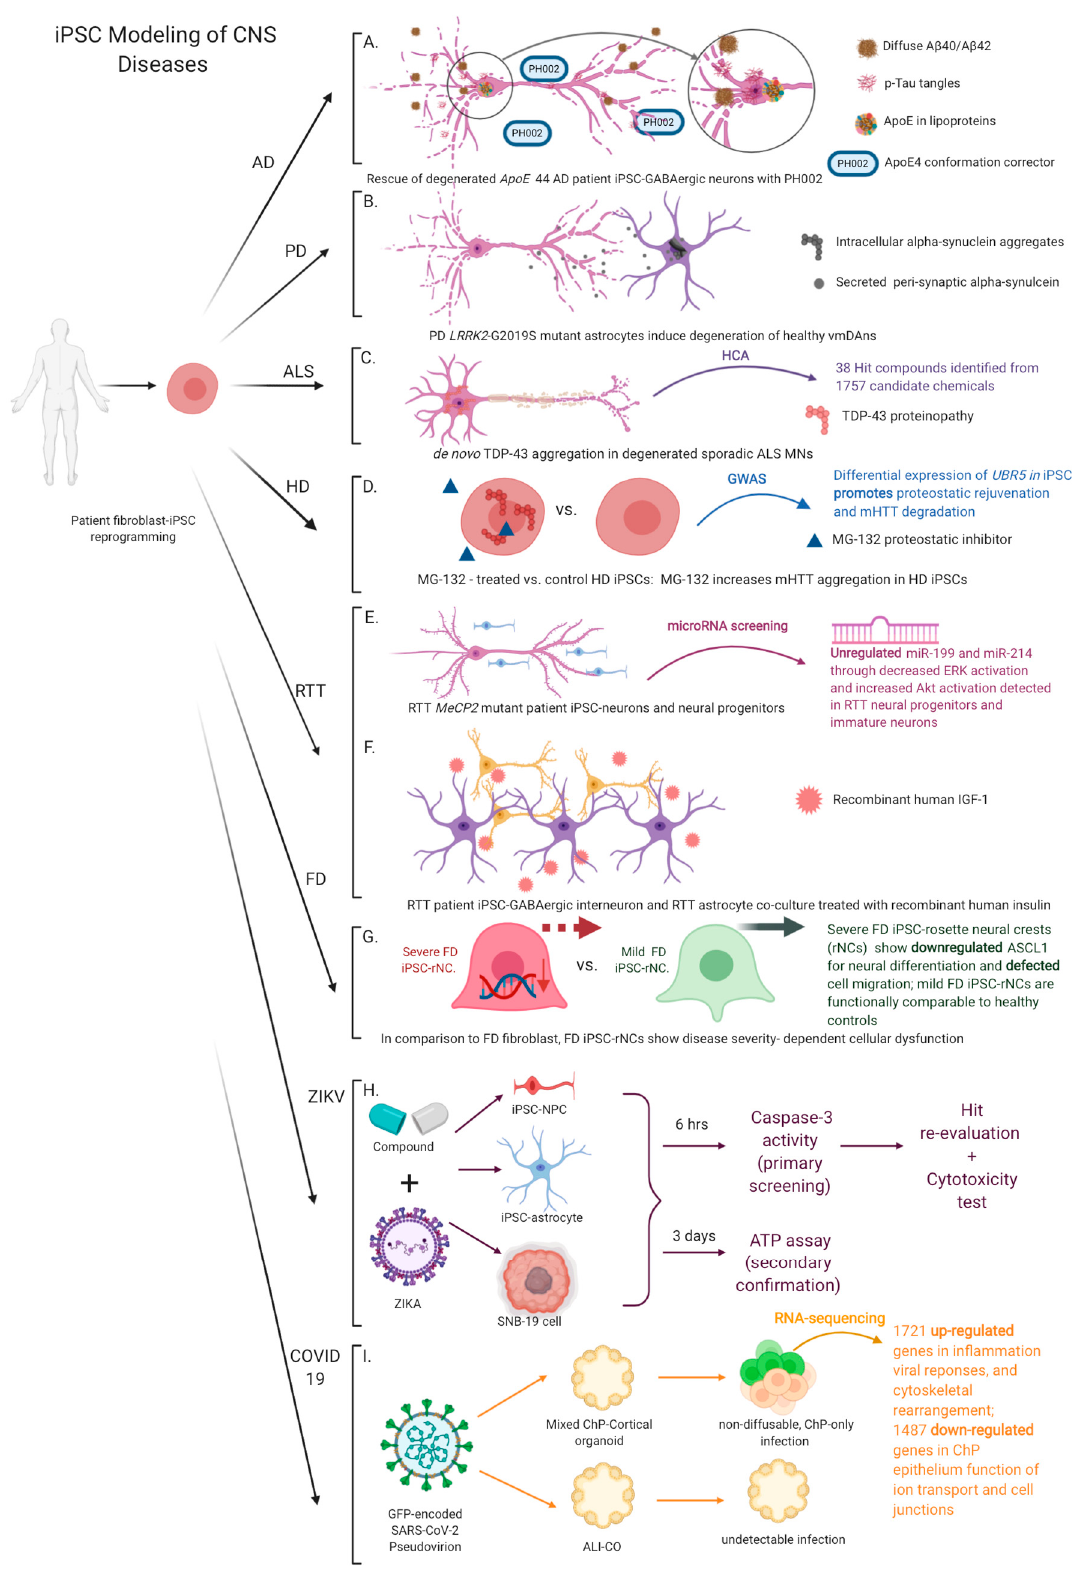
Figure 2. iPSC modeling of diverse CNS diseases for phenotype studies and drug discovery. ( A ) A proof-of-concept experiment to conformationally correct APOE4 in Alzheimer’s disease (AD) with the compound PH002. PH002 improves cytopathologies of APOE 44 human iPSC-GABAergic neurons with reduced p-tau accumulation, A β 40/A β 42 production/secretion, and ApoE4 fragments. ( B ) A co-culture model of astrocytes and ventral midbrain dopaminergic neurons (vmDAns) derived from Parkinson’s disease (PD) patient-specific iPSCs carrying LRRK2 G2019S mutation. Co-culture of